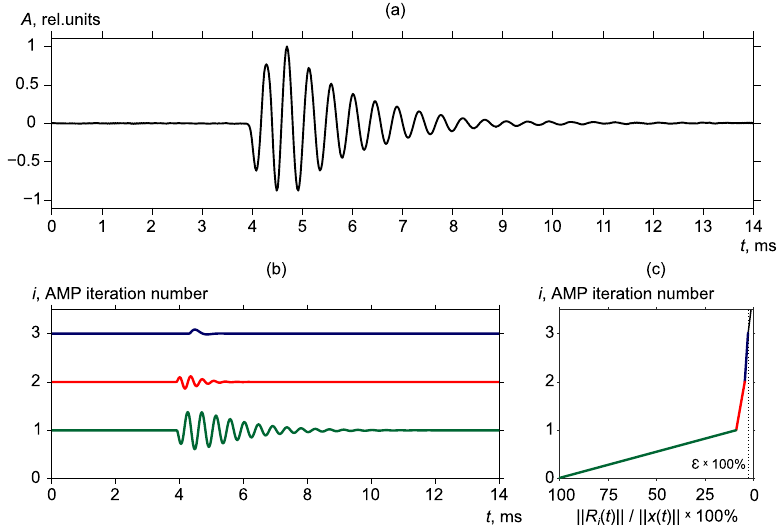
Figure 4. Example of geoacoustic pulse decomposition. ( a ) Geoacoustic pulse, ( b ) the first three atoms (each atom is marked by a different color) included into pulse decomposition, ( c ) graph of value (cid:107) R i ( t ) (cid:107) / (cid:107) x ( t ) (cid:107)